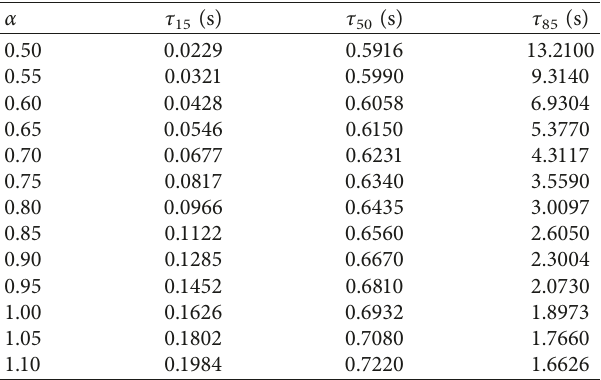
Table 3: Numeric values of normalized times τ different values of α .